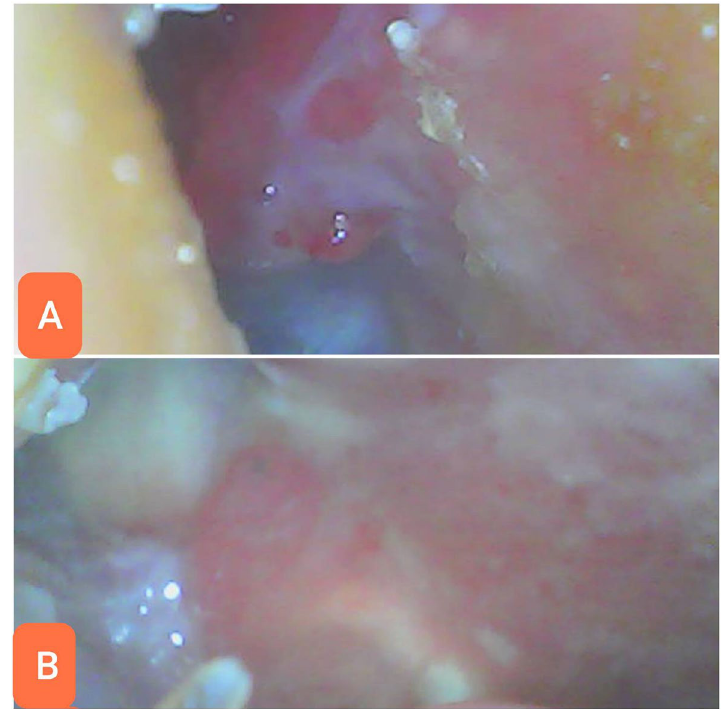
Fig. 1 Granulationtissue in tympanomastoidectomy ( A ) canal wall up ( B ) canal wall down 1 month after